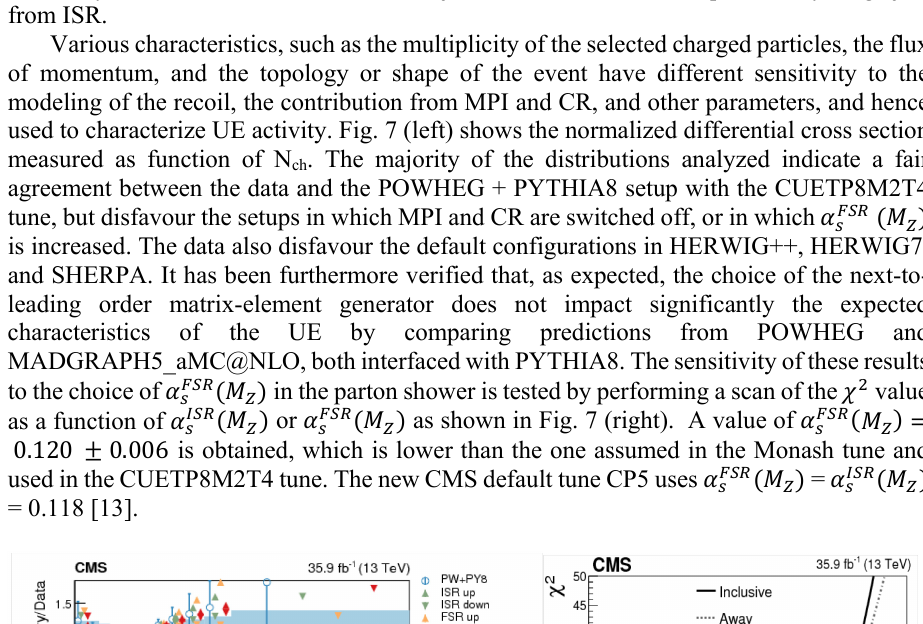
as a function of the value of 2 𝜒𝜒